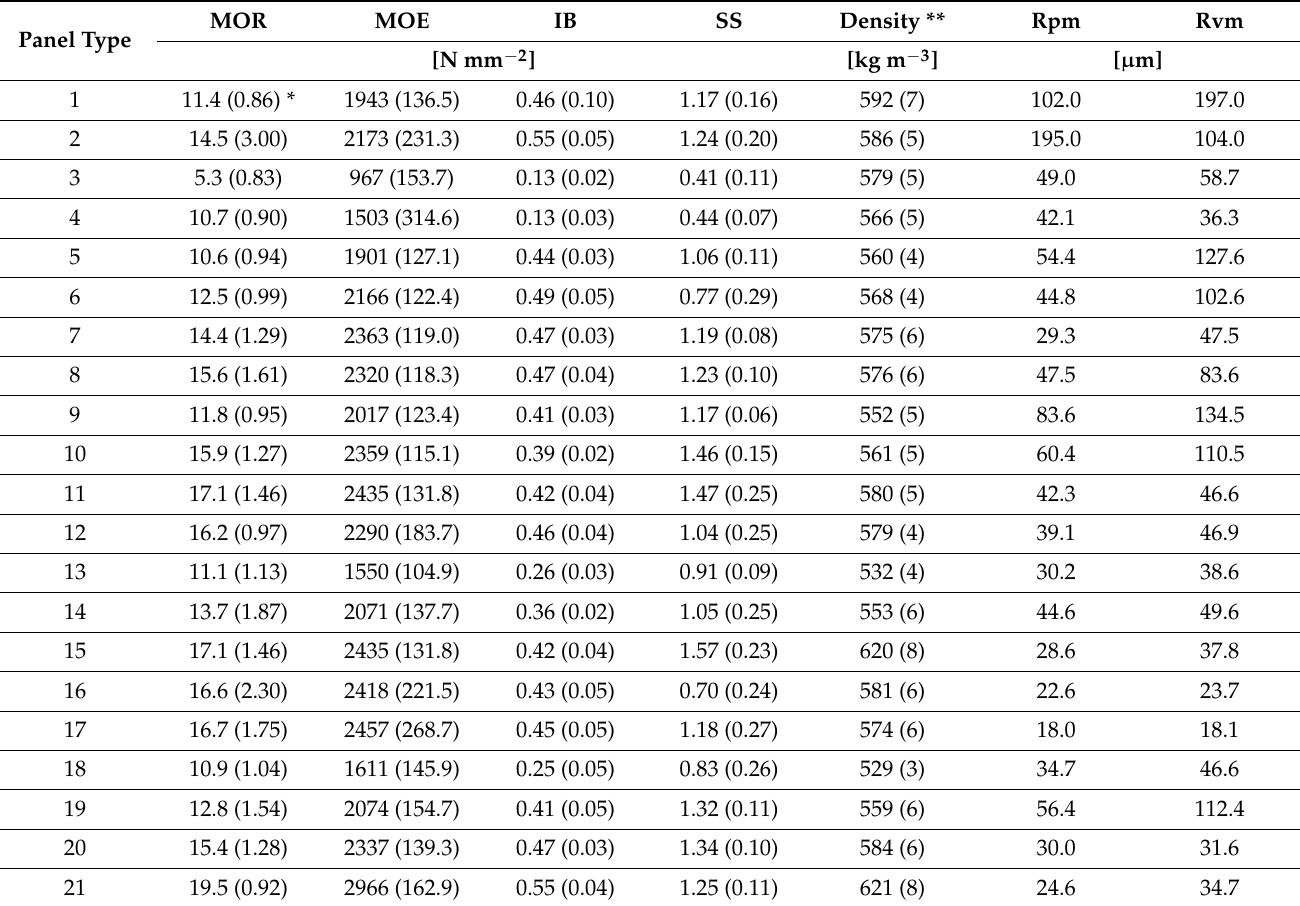
Table 2. The average values of achieved results of tested